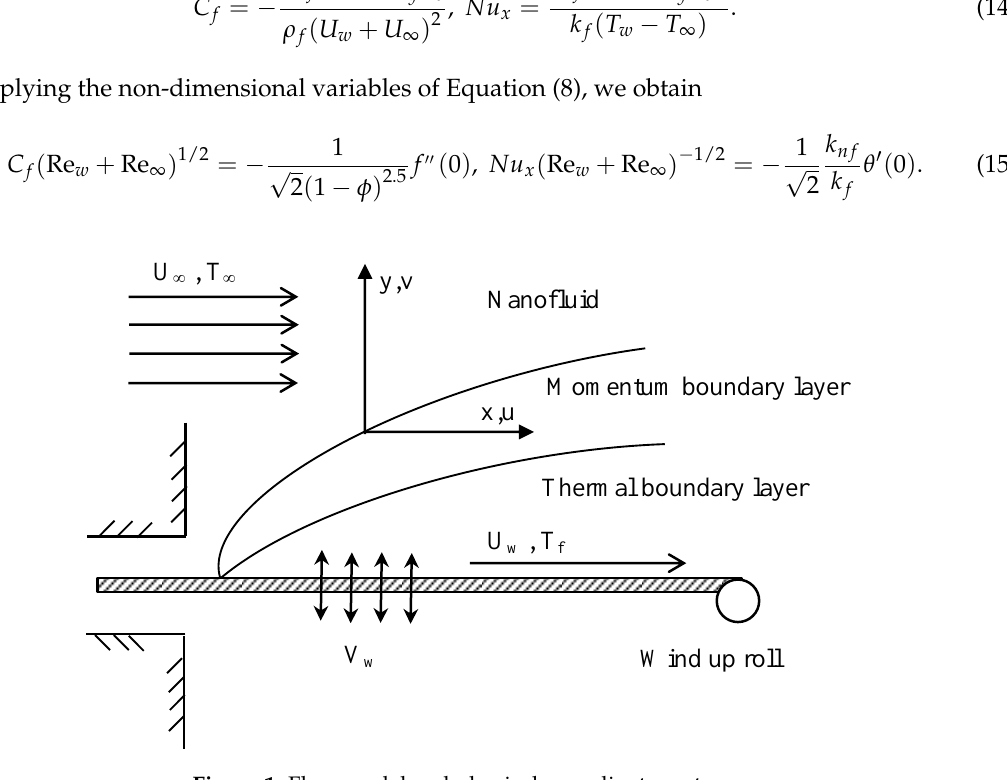
Figure 1. Flow model and physical co-ordinate system. Table 1. Physical properties of base fluid and iron oxide nanoparticles [24,25].